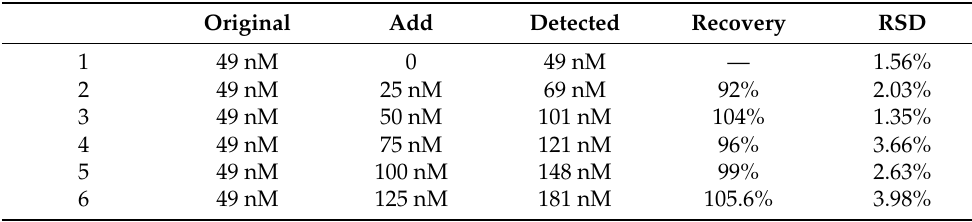
Table 2. Detection in real